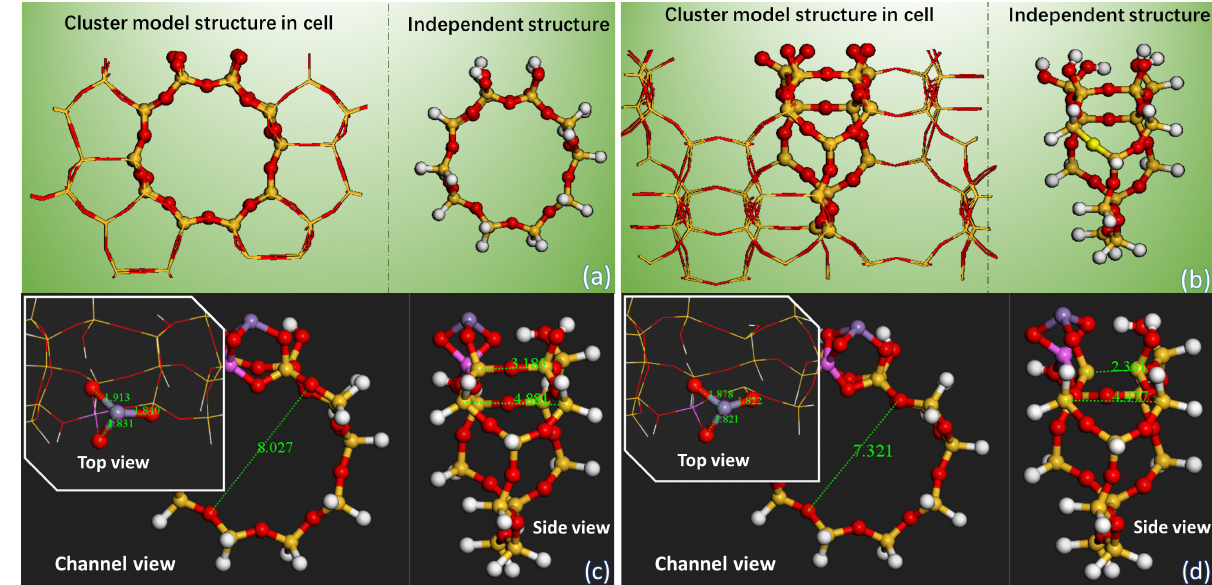
Figure 10. ( a ) Channel view and ( b ) side view of the ball and stick cluster model structure shown in the wire frame representation ZSM-5 cell; the partial atomic distances of the ( c ) original catalyst and ( d ) catalyst with the oxygen vacancy (White, red, yellow, pink and dark grey circles denote H, O, Si, Al and Mn atoms, respectively).